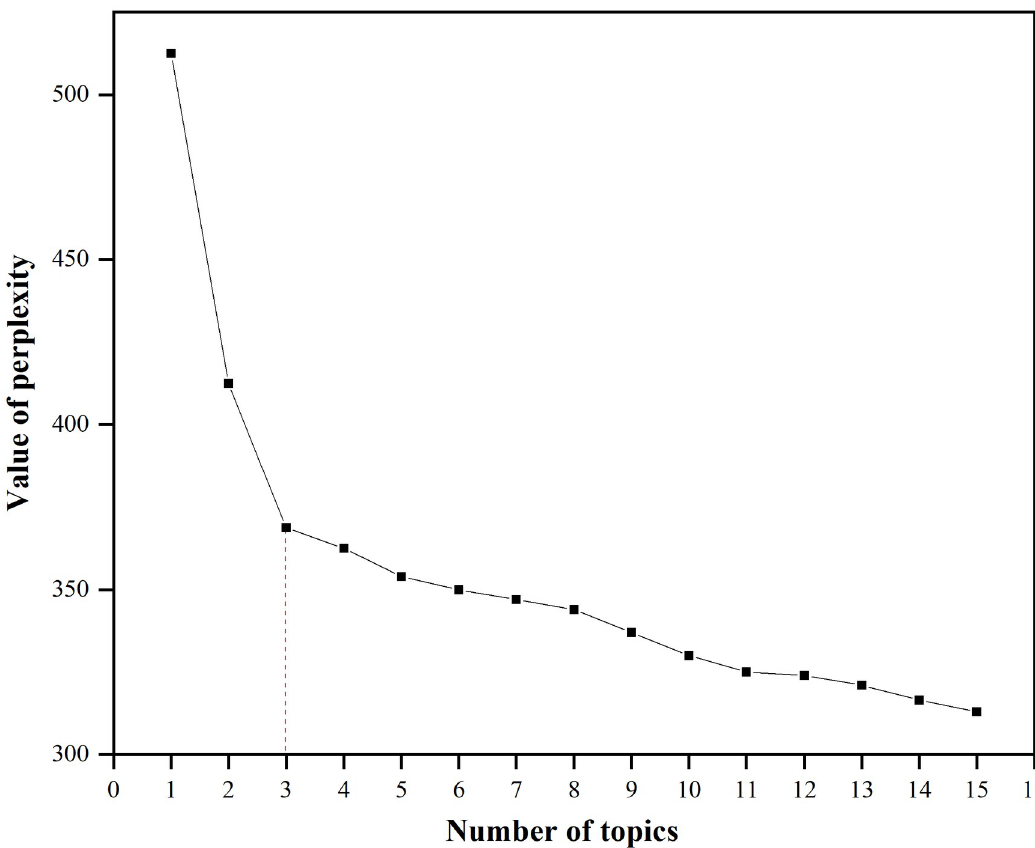
Fig 10. Variation in perplexity of the LDA model from 0 to 15